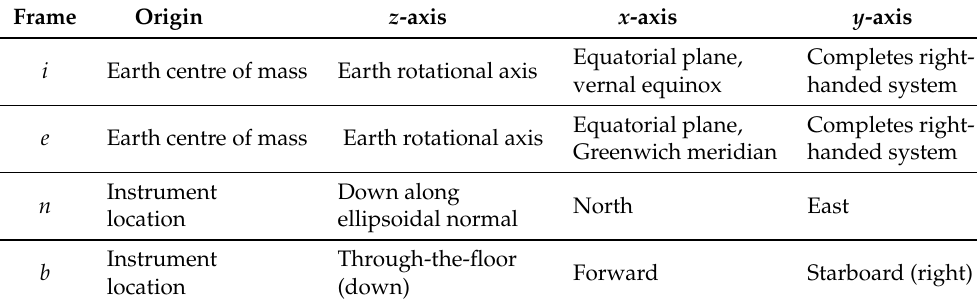
Table 3. Overview of relevant reference